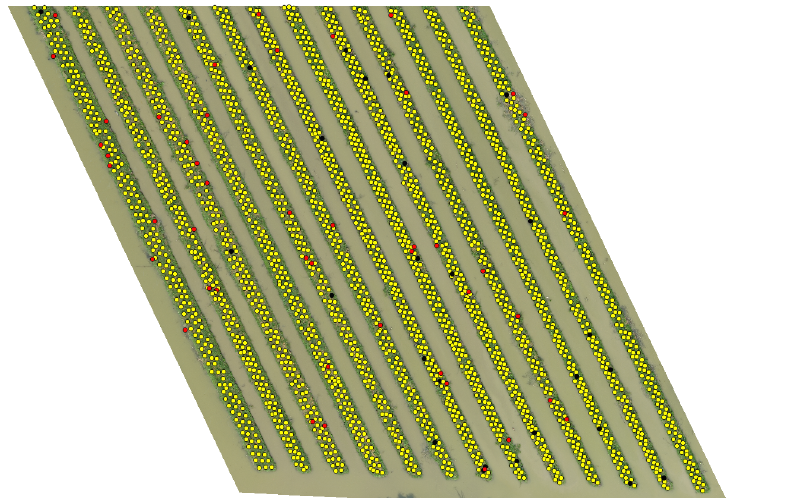
Fig 11. Detection results of combination